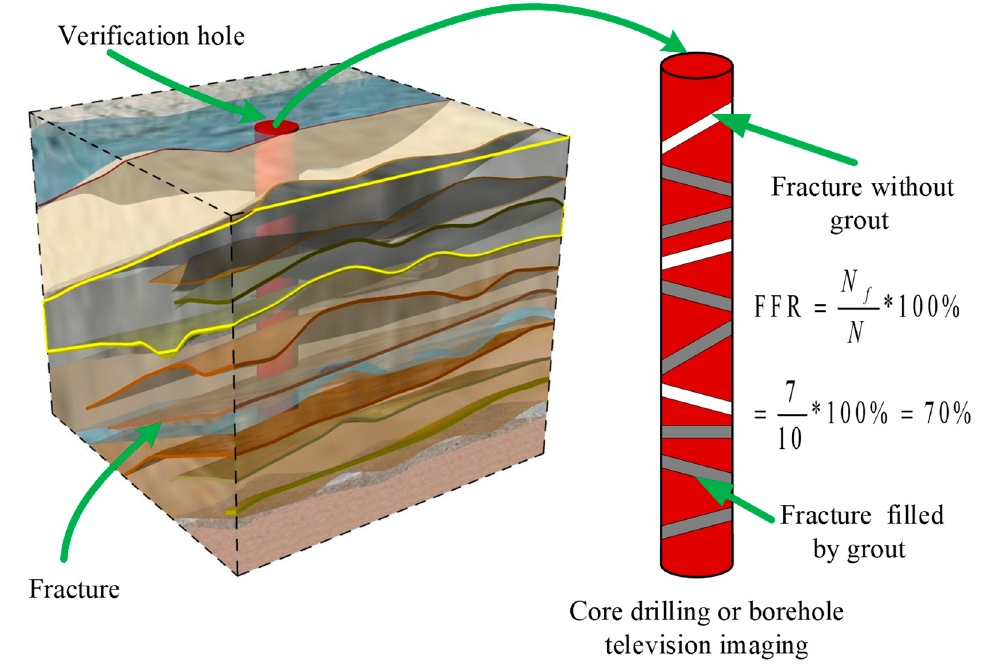
Figure 3. Schematic diagram for the calculation of Fraction-Filled Rate (FFR) .